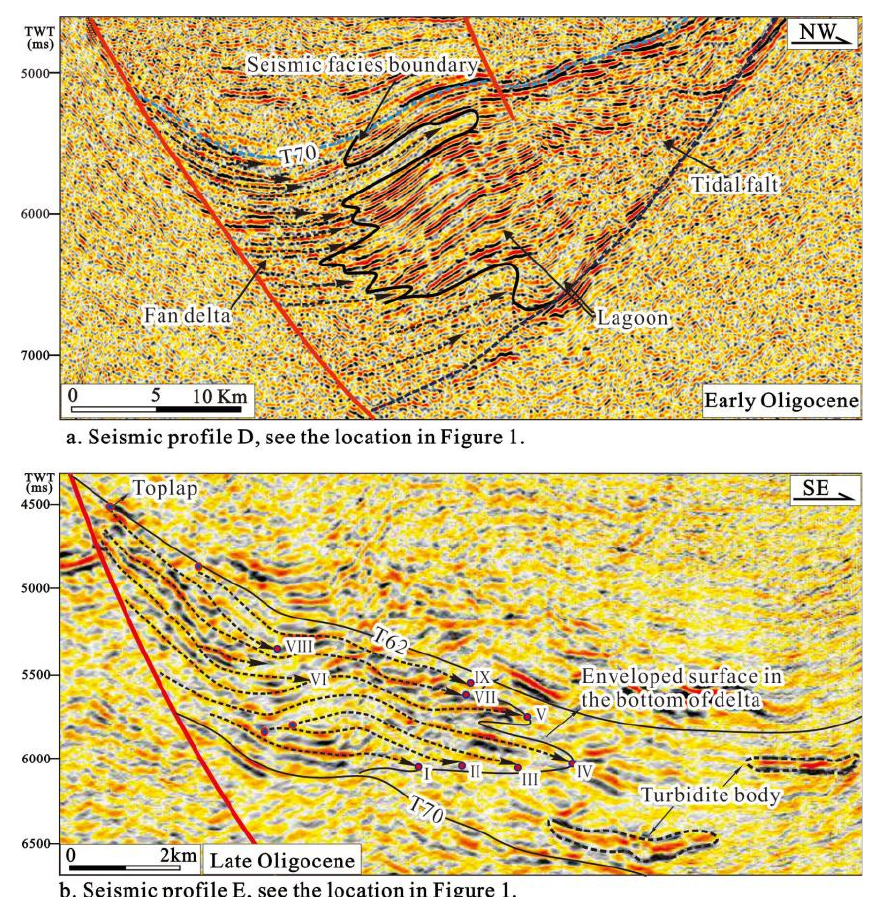
Figure 9. The basin-marginal fans that developed in different phases. ( a ) The fans formed before T70 (Phase-I and Phase-II), with a limited extension scale, no sliding deposit, and only one toplap point that developed; ( b ) The fans formed after T70 (Phase-III), with a longer extension scale, turbidite bodies developing in the front, and more top-lap points that developed.